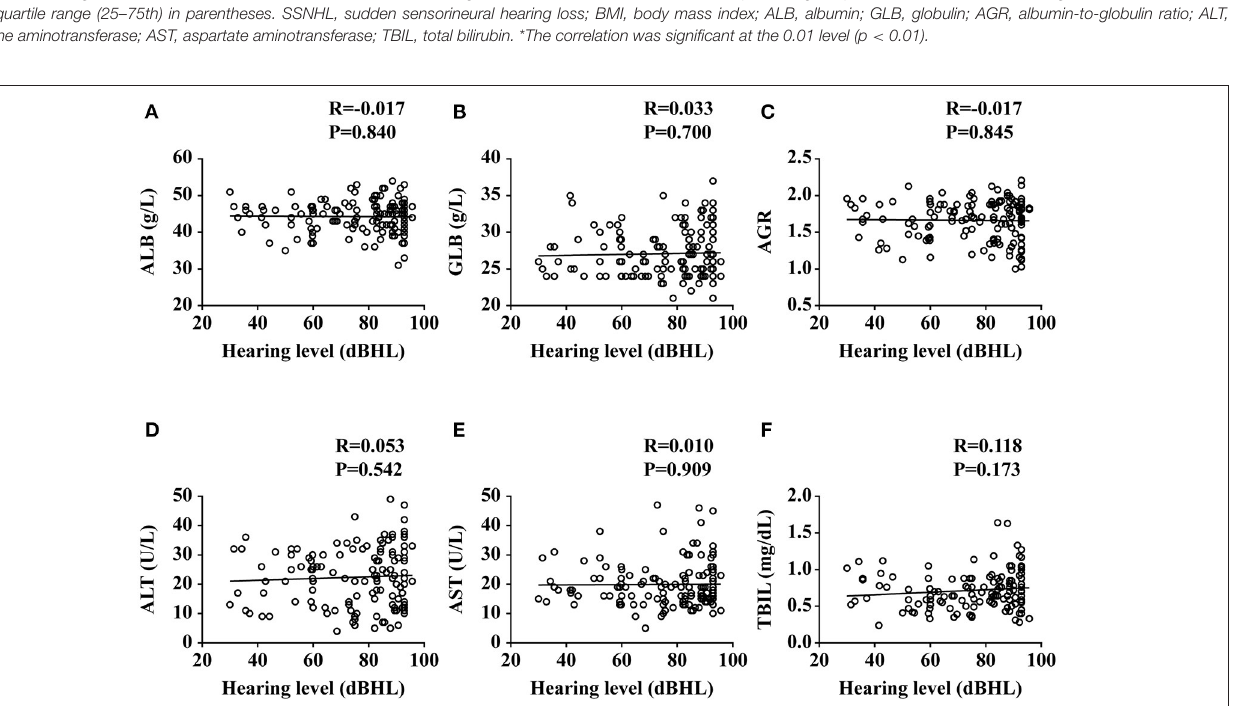
FIGURE 1 | Plots of liver functions vs. the severity of hearing loss. ALB, albumin; GLB, globulin; AGR, albumin-to-globulin ratio; ALT, alanine aminotransferase; AST, aspartate aminotransferase; TBIL, total bilirubin. Data are presented as correlation coefficients (R) and P values. (A–F) represent the relationship of ALB, GLB, AGR, ALT, AST, and TBIL vs. the severity of hearing loss,